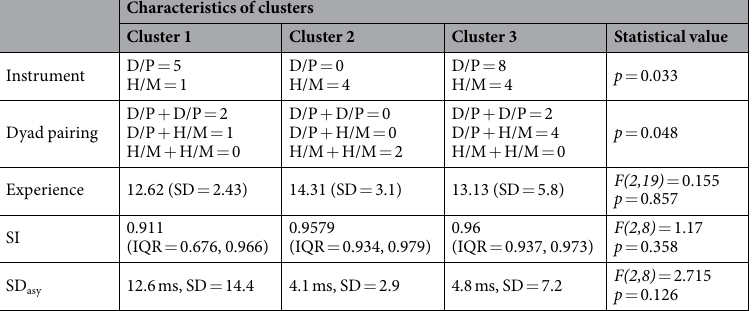
Table 2. Characteristics of clusters. For instrument and dyad pairing, we performed a Fisher’s exact test. For experience, SI and SDasy, a one-way ANOVA were performed. We report the median and interquartile range for data that was not normally distributed, and mean and standard deviation for normally distributed